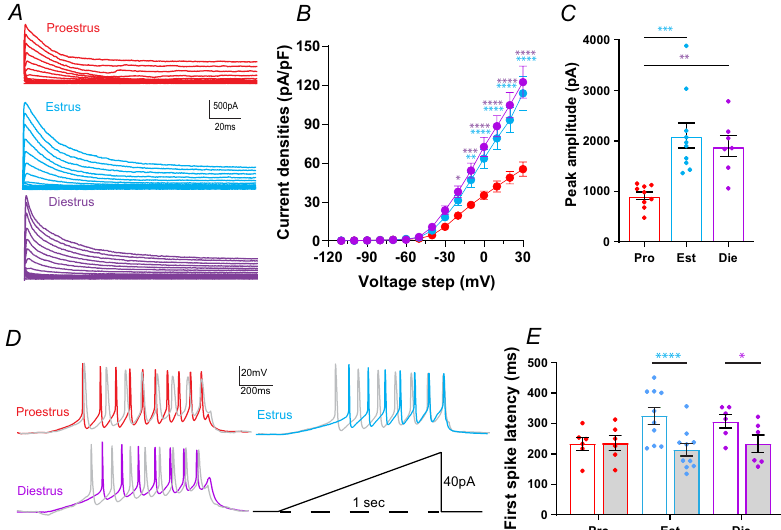
Figure 2. I A currents vary across the estrous cycle influencing FSL. ( A ) Example I A currents evoked from individual cells during each cycle stage; proestrus (red), estrus (blue) and diestrus (purple). ( B ) I A current densities plotted for each 10 mV voltage step. Cells from proestrus (n = 8) animals had significantly smaller I A currents compared to those from estrus (n = 9) and diestrus (n = 7) animals. ( C ) Peak amplitude I A currents (not normalized to capacitance) evoked by a + 30 mV step. Peak I A currents during proestrus were significantly smaller than during other cycle stages. ( D ) Example traces showing CRH neuron spiking response to a one second current ramp protocol (bottom right). Grey traces are example traces from each group in the presence of 4-AP. ( E ) Bar graph of first spike latency, measured from the onset of the ramp to AP threshold, for each group under control conditions and in the presence of 4-AP (grey bars). 4-AP had a significant effect on FSL in cells from estrus and diestrus animals but did not affect FSL in proestrus animals. Results of one and two-way ANOVAs reported in Supplementary Table 1. Star symbols denote significance by Tukey’s multiple comparisons test, purple: diestrus versus proestrus, blue: estrus versus proestrus. There were no significant differences between estrus and diestrus groups. N = 5–8 mice for all groups. P values: * ≤ 0.05, ** ≤ 0.01, *** ≤ 0.001, **** ≤